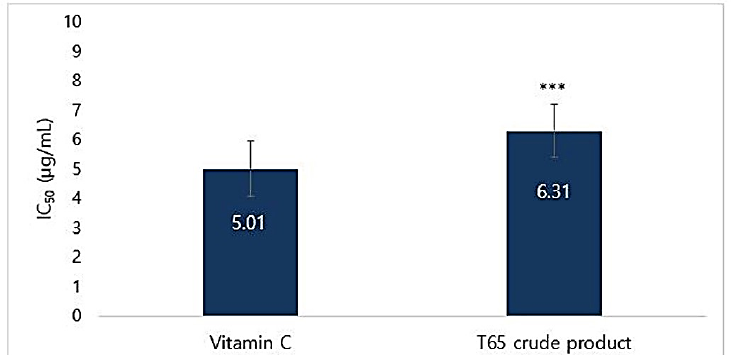
Figure 3. IC 50 of 1,1-diphenyl-2-picrylhydrazyl (DPPH) radical scavenging activities of T65 crude product and vitamin C. Data are given as mean ± SEM. Statistical significance is shown by ANOVA (*** p < 0.001).